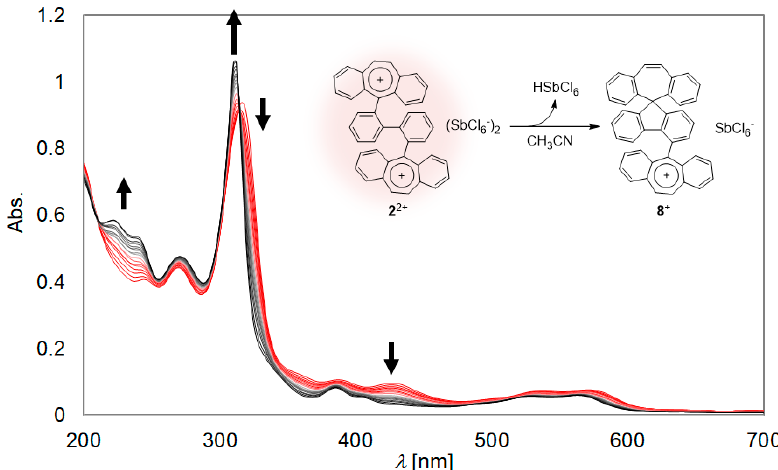
Figure 9. ORTEP drawings of ( a ) 2 2+ (SbCl 6 − ) 2 ·2(CH 2 Cl 2 ) and ( b ) 8 + (SbCl 6 − )·(CH 3 CN) at 150 K. Solvent molecules are omitted for clarity and thermal ellipsoids are shown at the 50%